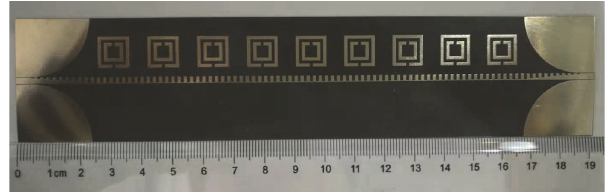
Figure 14: Photograph of proposed antenna.